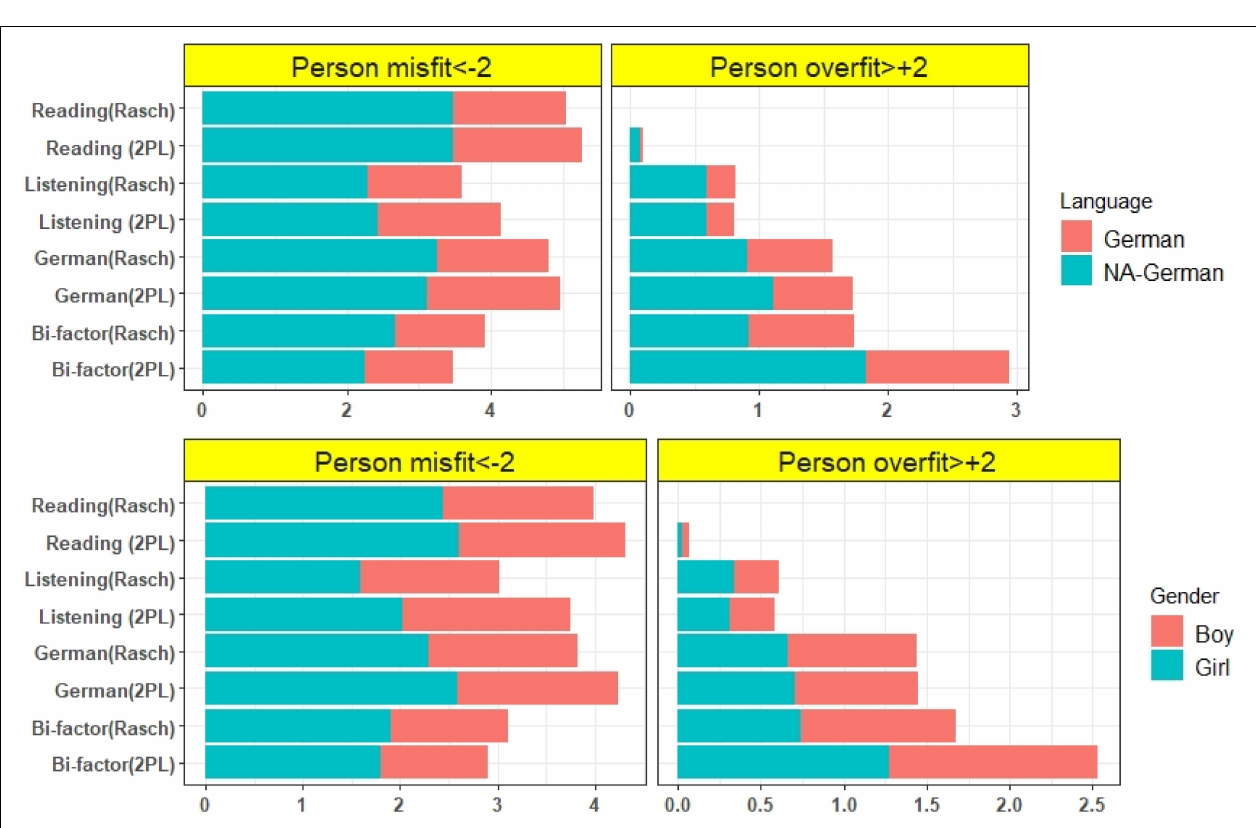
Frontiers in Education |